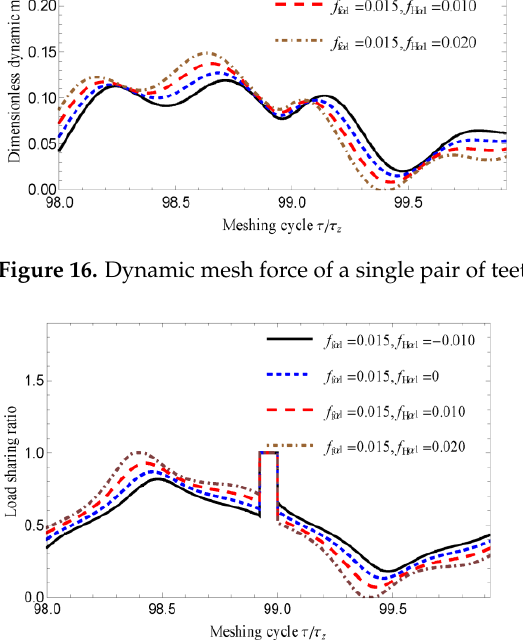
Figure 17. Dynamic mesh force of a single pair of teeth under different 𝑓 𝐻𝛼1 .